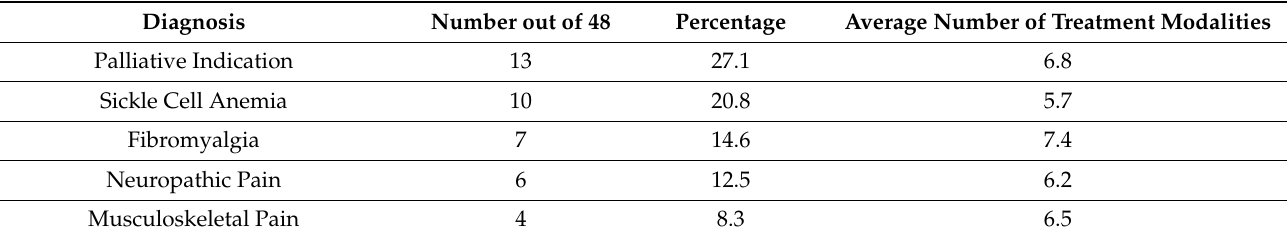
Table 2. Indication for chronic opioid therapy